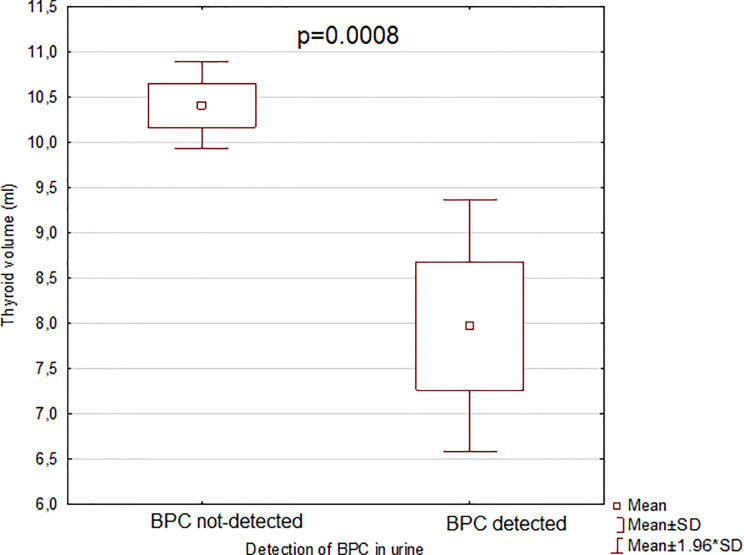
Comparison of thyroid volume according to the detection of bisphenol C (BPC) in urine (n = 177). BPC, bisphenol C; SD, standard deviation. The term “detected” means that the concentration of bisphenol C was above the limit of detection (LOD) presented in Table S1, see Supplemental Material. The term “not-detected” means that the concentration of bisphenol C was below the LOD. The comparison was performed with the Mann-Whitney U test. After Bonferroni correction results were claimed statistically significant with p < 0.0033.